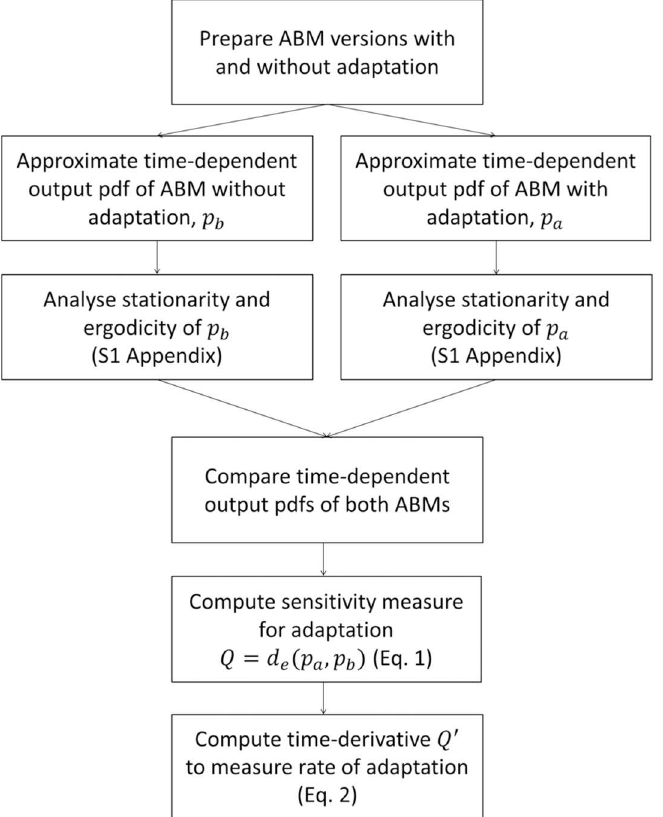
Fig 3. Flow chart of the proposed method to measureadaptation. The method is basedon a comparison betweenversions of an ABM with and without adaptation. See the main text for further